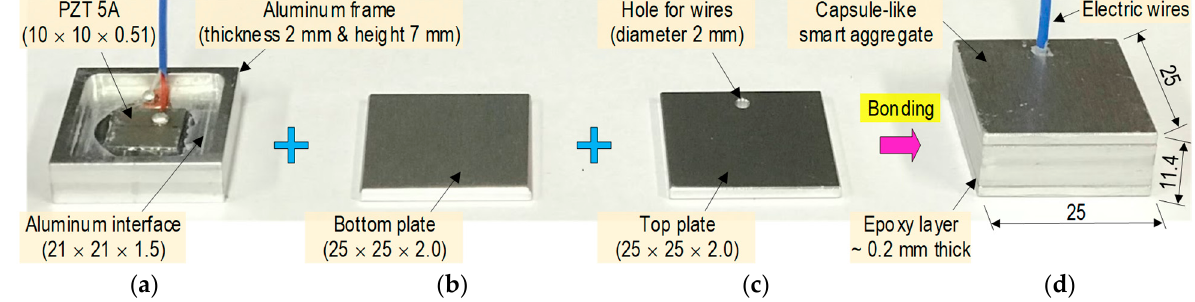
Figure 12. Fabrication of CSA prototype (dimension in mm). ( a ) PZT interface. ( b ) Bottom cover. ( c ) Top cover. ( d ) CSA.